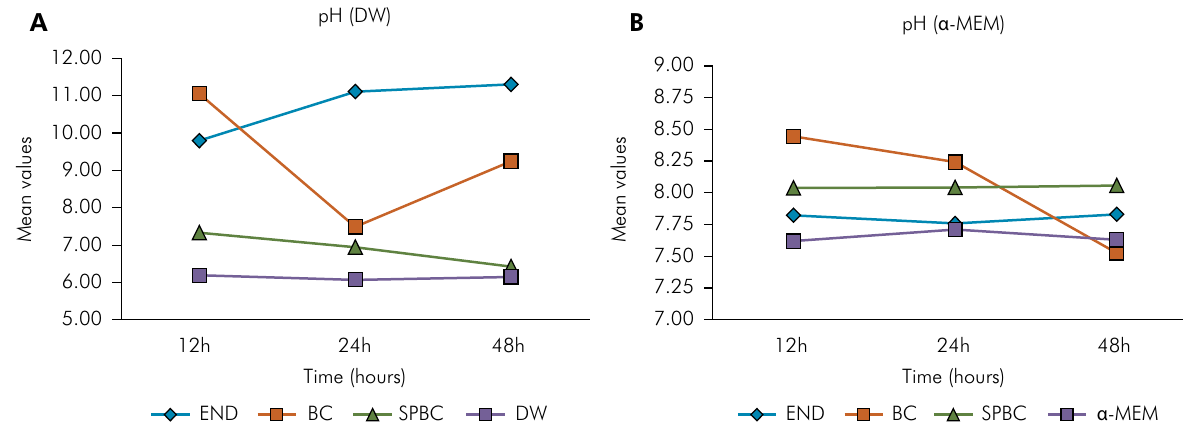
Figure 1. Graphic representation of mean pH curves for all calcium silicate-based sealers, compared with the control soaking solutions at the different experimental time periods. (A) After immersion in DW; and (B) after immersion in α -MEM.